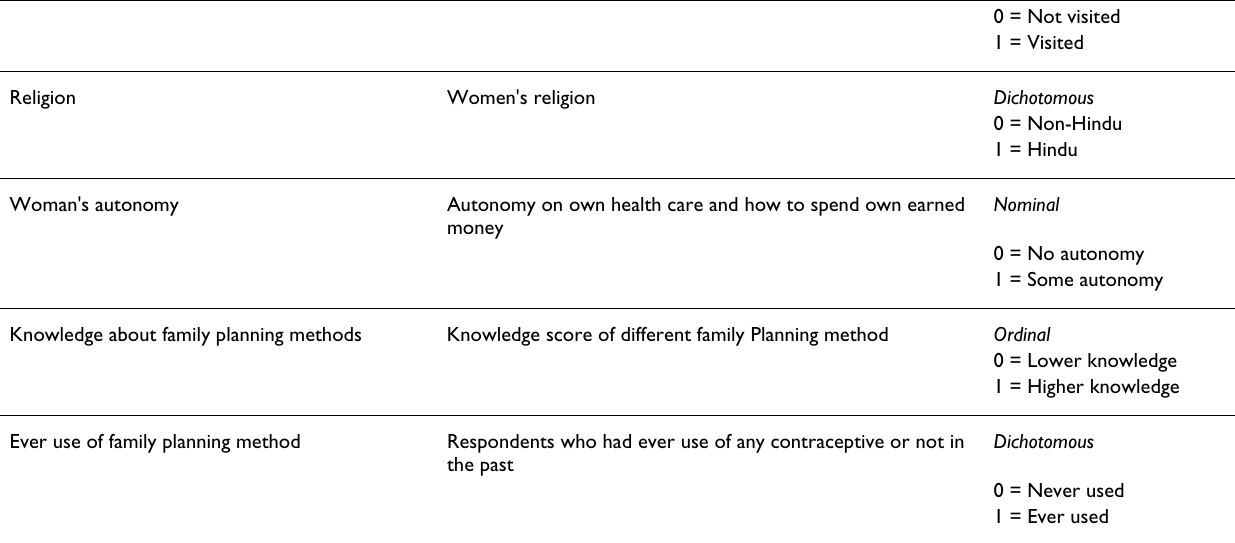
Table 1: Operational definitions of variables and their measurements